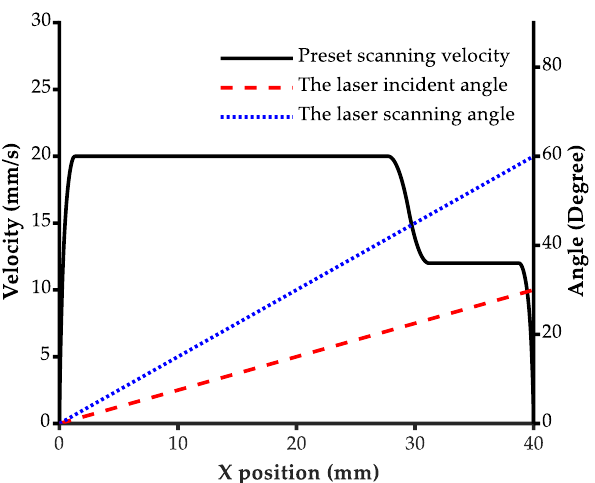
Figure 5. The preset scanning velocity and laser beam angles in the straight groove laser engraving experiment.